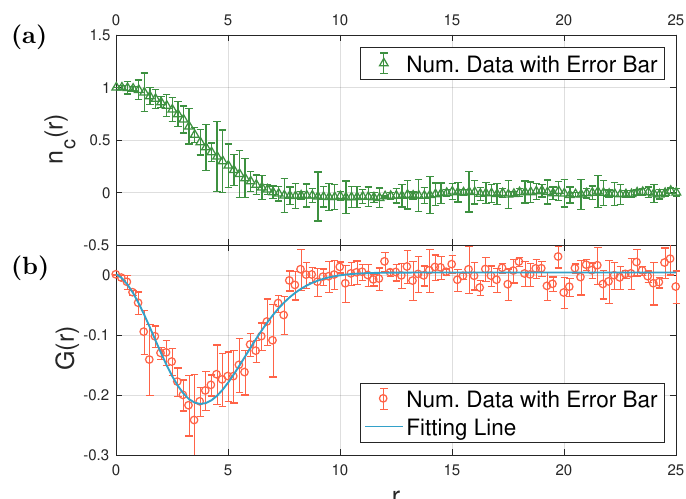
Figure 5. Net vortex number n c ( r ) and vortex-vortex correlation function G ( r ) . (a) Profile of net vortex number n c ( r ) . It decreases from 1 at r = 0 to 0 at large r , indicating vortex-antivortex correlations. Error bars stand for the standard deviations. (b) Profile of vortex-vortex correlation function G ( r ) . Minimum of the fitting curve indicates the correlation length as ˆ ξ ≈ 3 . 7712 . Param- eters τ Q and T f are the same as figure